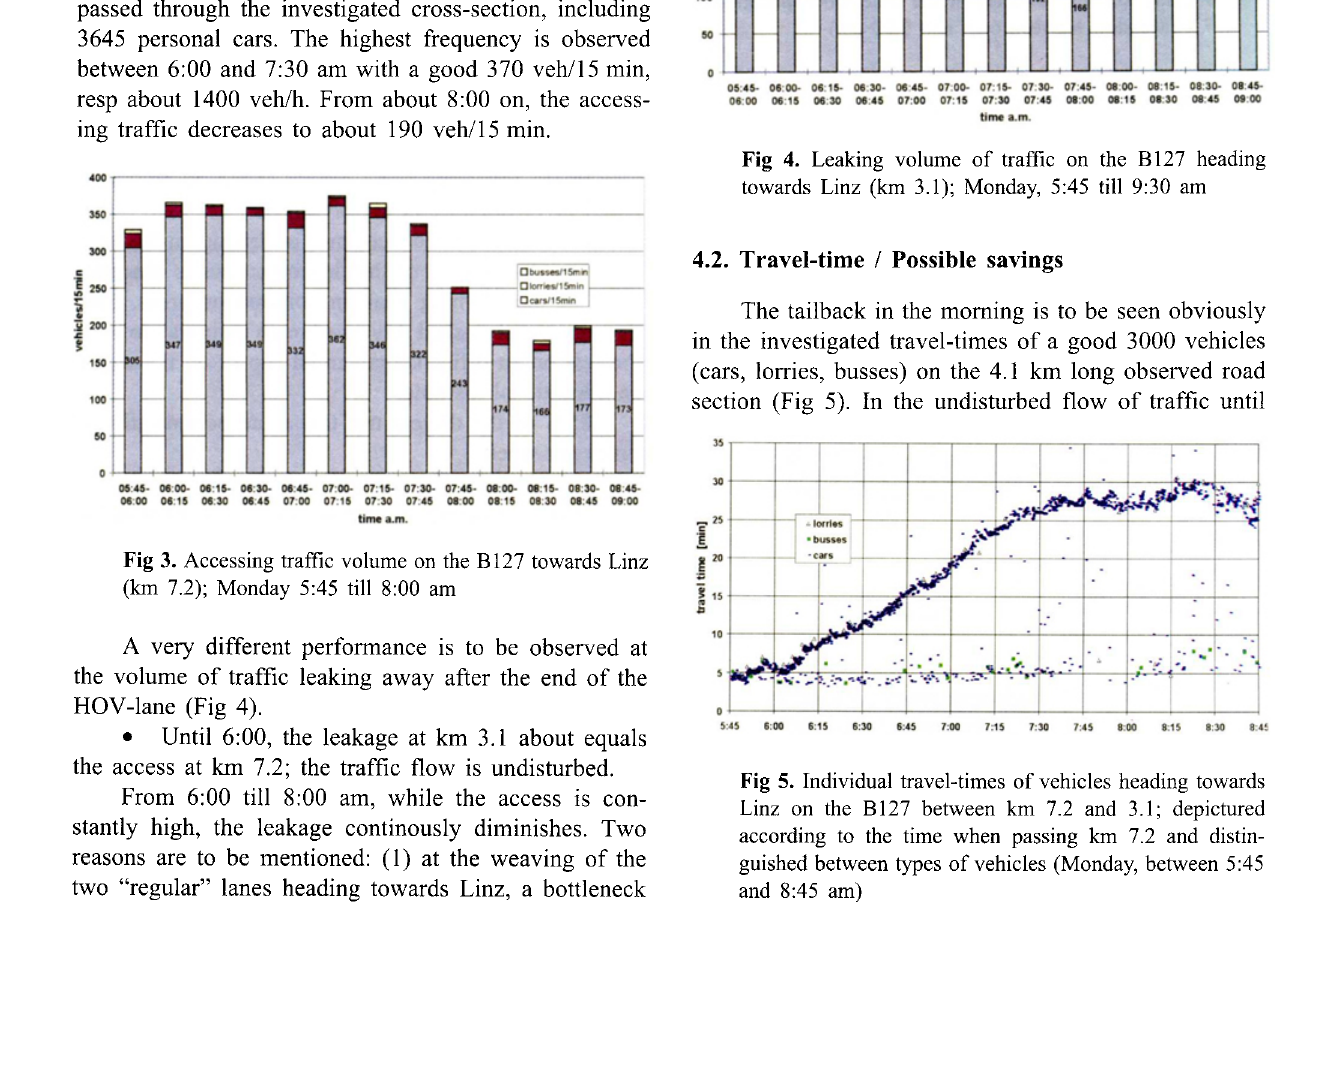
Fig 4. Leaking volume of traffic on the Bl27 heading